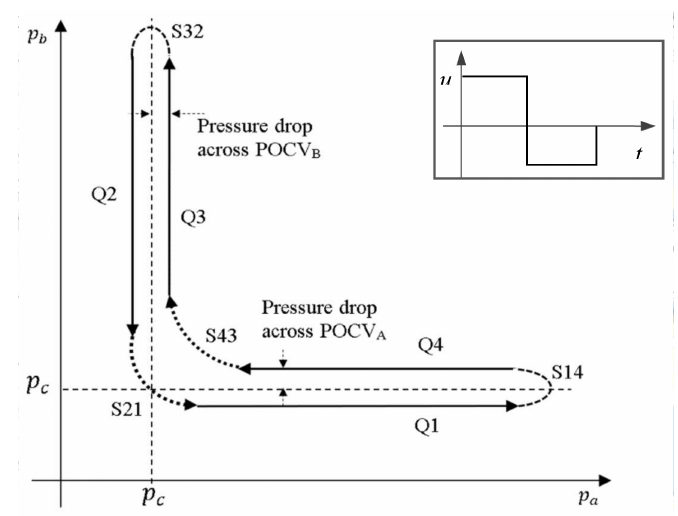
Figure 4. Pressure plane of pump given the square input signal shown in the